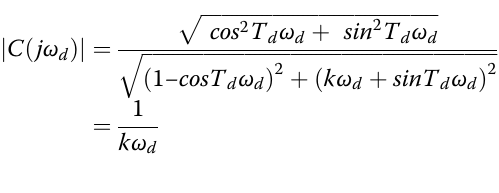
Fig. 6 Structure of IPFC main controller based on